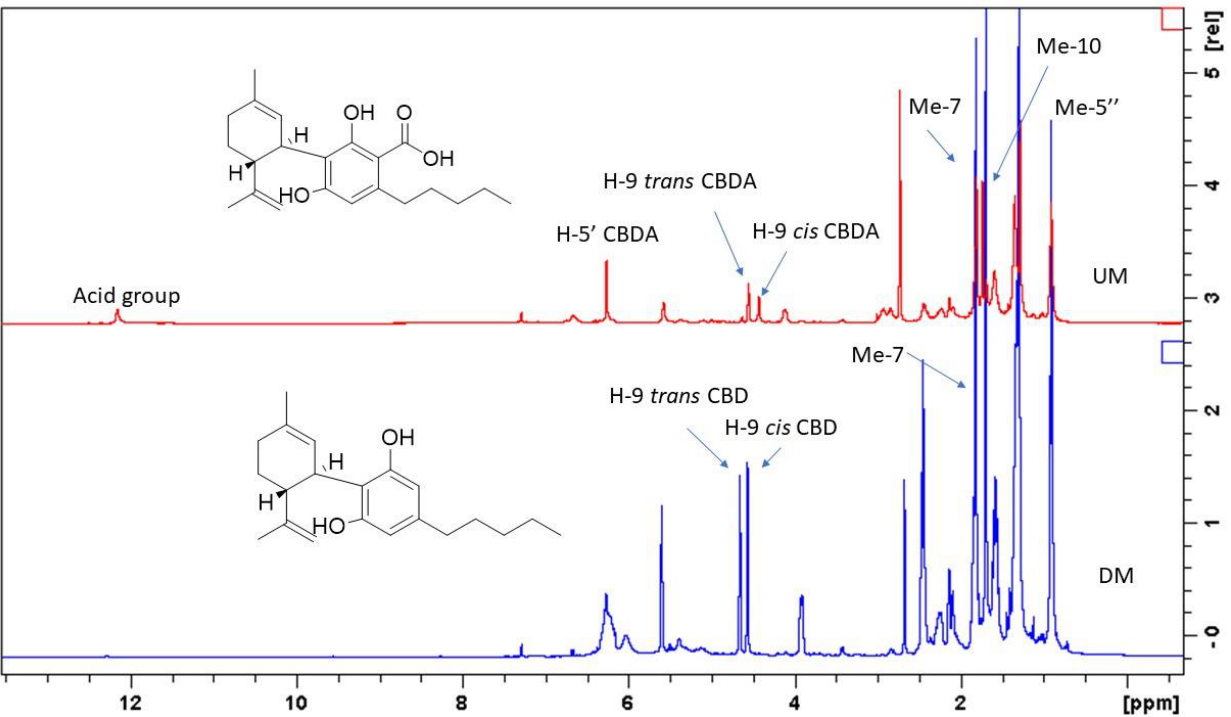
Figure 3. 1 H-NMR spectra showing the cannabinoids profiles of UM and DM chloroform extract.